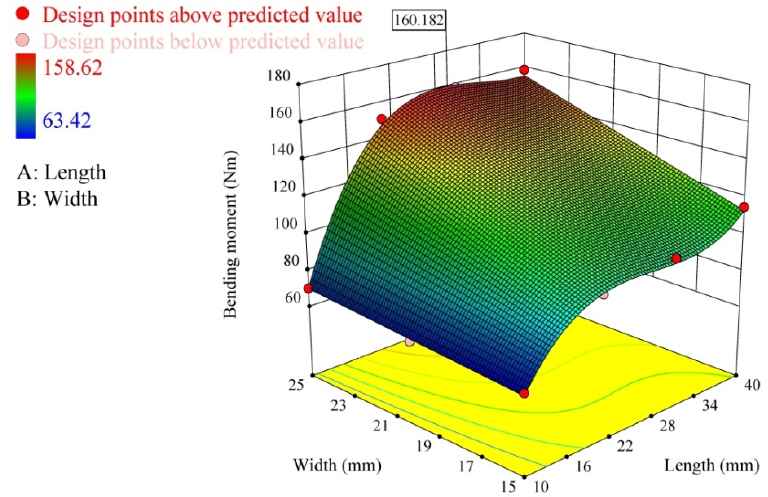
Figure 6. Response surface model of bending moment relating to tenon width and tenon length. Table 5. ANOVA of response surface reduced cubic